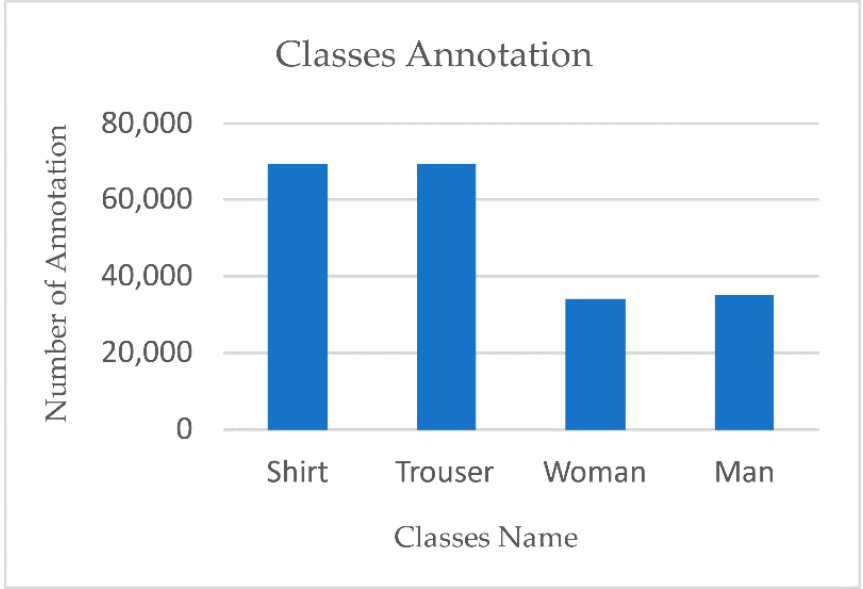
Figure 4. PGC class annotation balance.